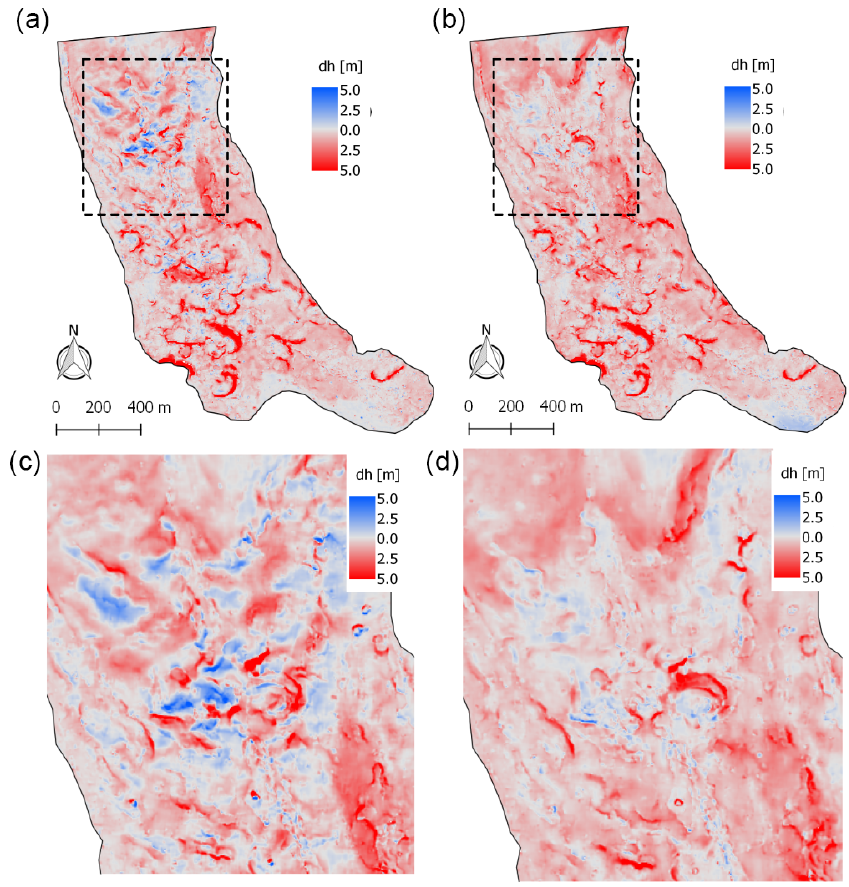
Figure 5. Panels showing maps of elevation change from Pléiades (a, c) before flow correction and (b, d) after flow correction over the period 22 November 2015–13 November 2016. Panels (c) and (d) are close-ups of the panels (a) and (b)